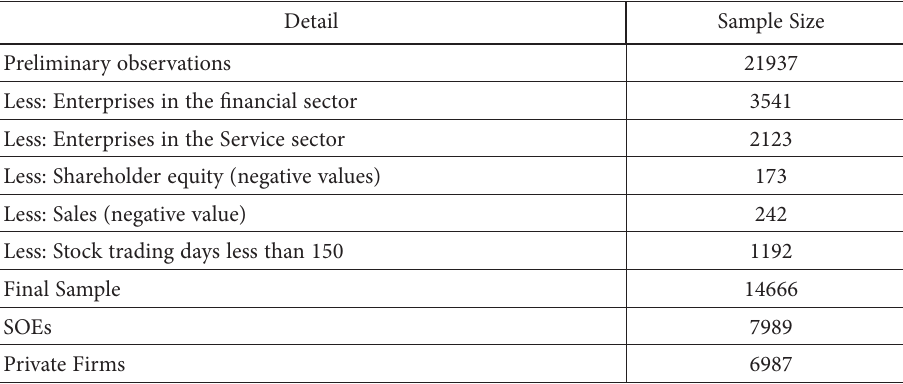
Table 1. Final sample